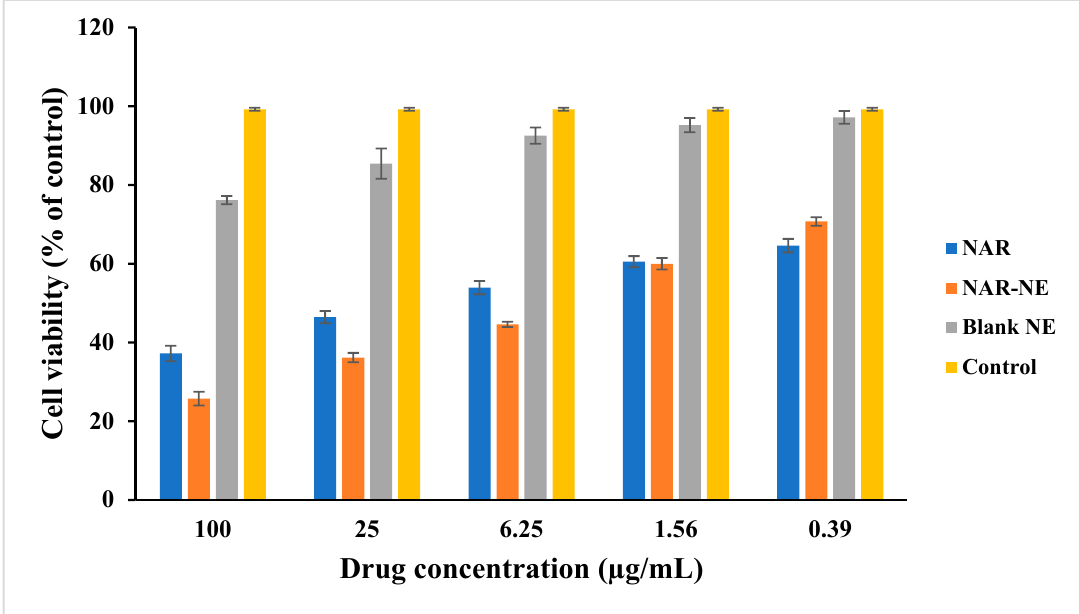
Figure 9. MTT results of in the vitro cell viability of the control group, free NAR, blank NE, and NAR-NE against A549 cells incubated for 24 h. The data are presented as the mean ± SD ( n = 3). p < 0.05 for free NAR and NAR-NE at 6.25, 25, and 100 μ g/mL.